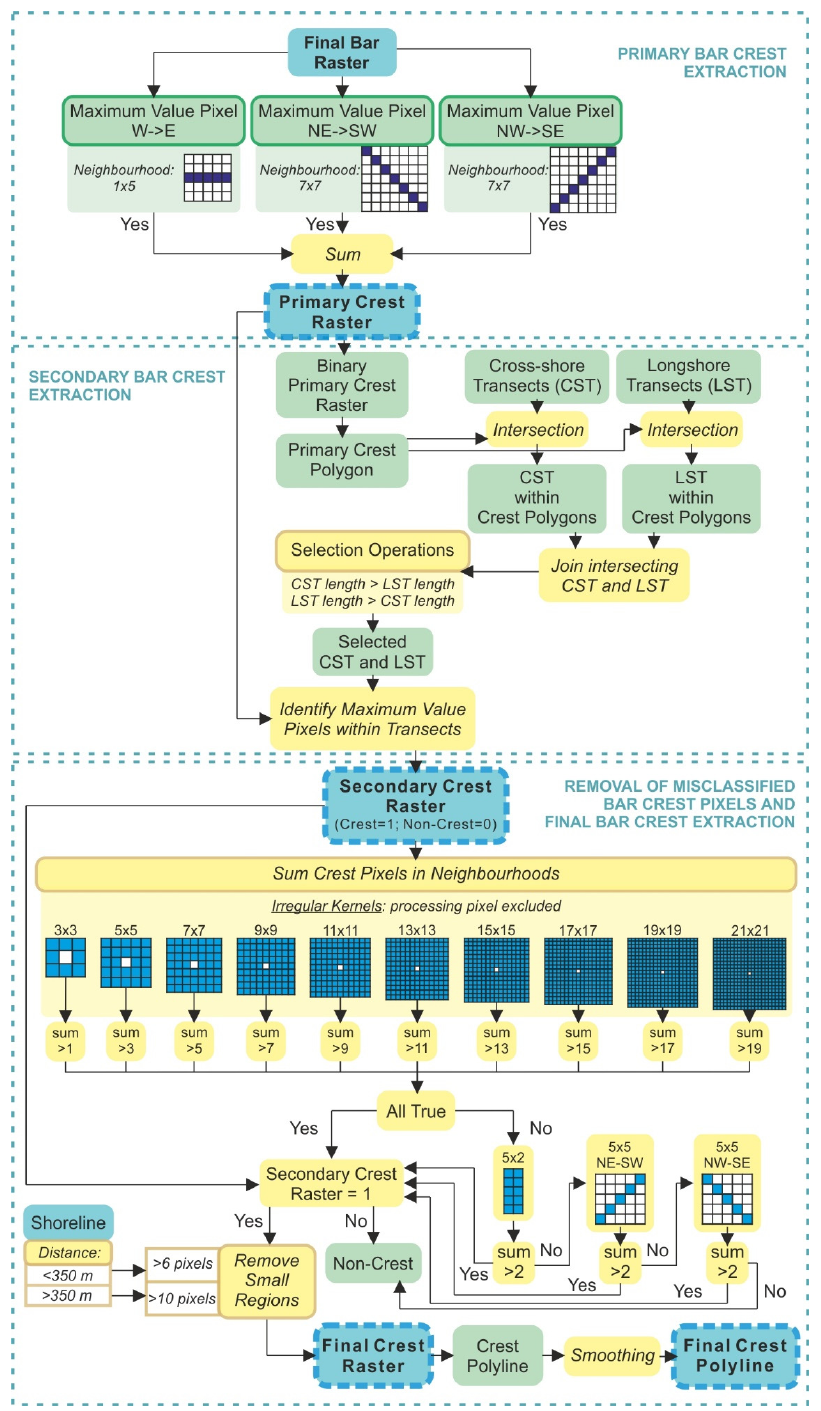
Figure 8. A flowchart of the sandbar crest extraction procedure: at first, the primary crest as maximum value pixels within three kernels are identified, then secondary crest with cross-shore/longshore transects is extracted, and the final bar crest is obtained after cleaning procedure with proximity- based